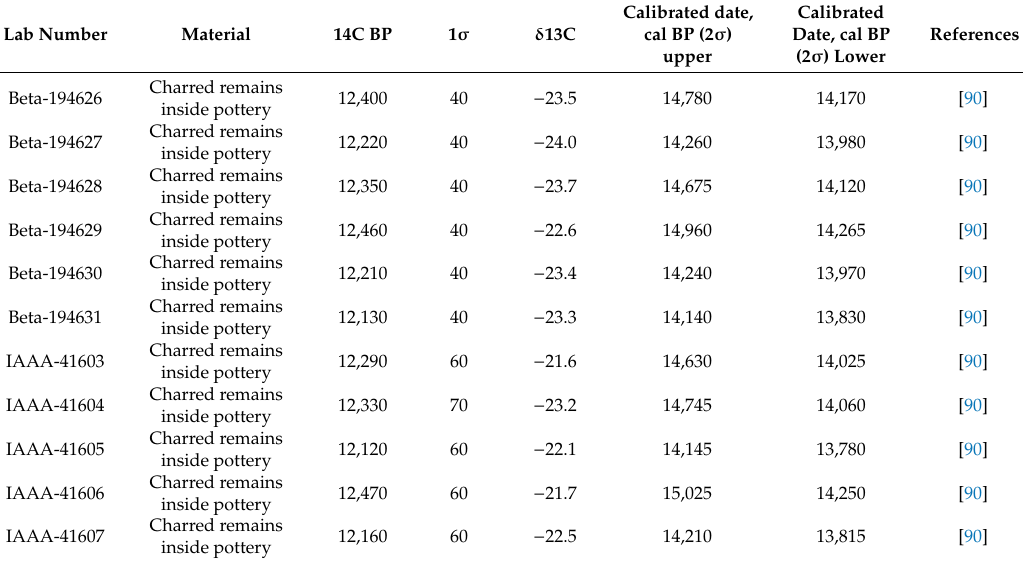
Table 1. AMS radiocarbon dates from the Taisho-3 site (calibrated using IntCal